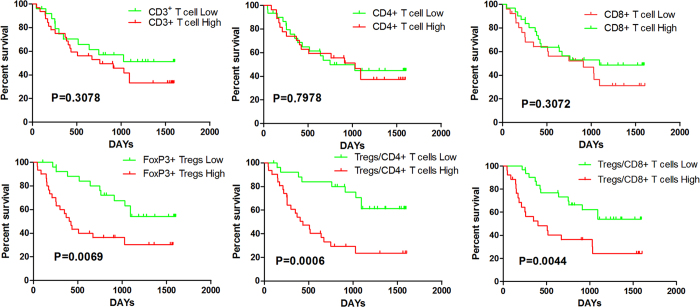
Kaplan-Meier survival curves using the log-rank test to further investigate their association with OS.